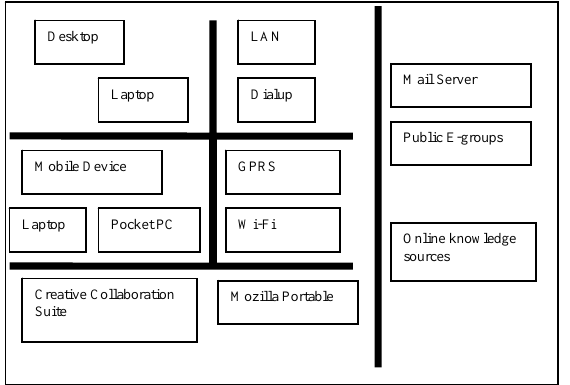
Figure 4 – Implementation block